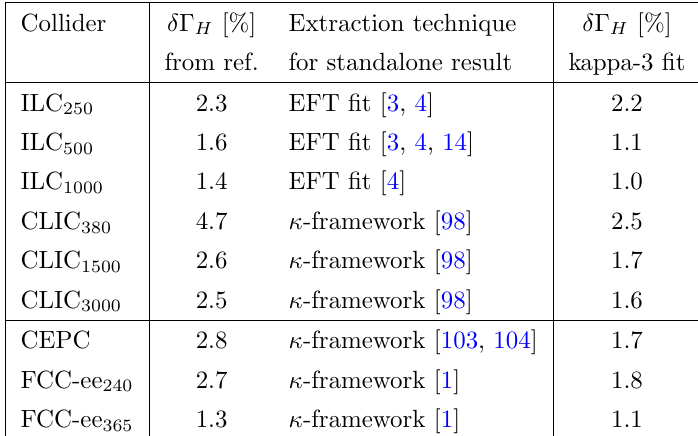
Table 17 . Overview of expected precision of Higgs boson width measurements for future accelerator scenarios. The result given in the second column refers to the width extraction as performed by the future lepton colliders using the stated technique, and as provided in the references given. The last column of the table lists the width extracted from the kappa-3 scenario (cid:12)t. It also includes the HL-LHC measurements (but excludes the constraint (cid:20) V < 1 that is used in HL-LHC-only (cid:12)ts). and channels ( e + e (cid:0) ! H(cid:23) (cid:22) (cid:23) ). This method is used for CEPC. For FCC-ee and CLIC